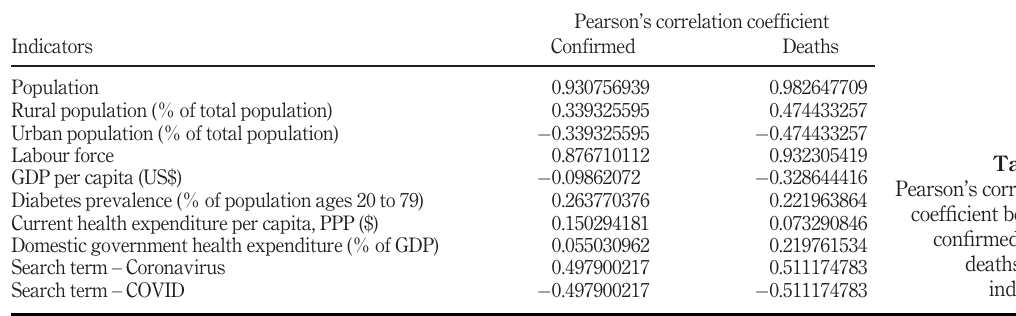
Table 1. Pearson ’ s